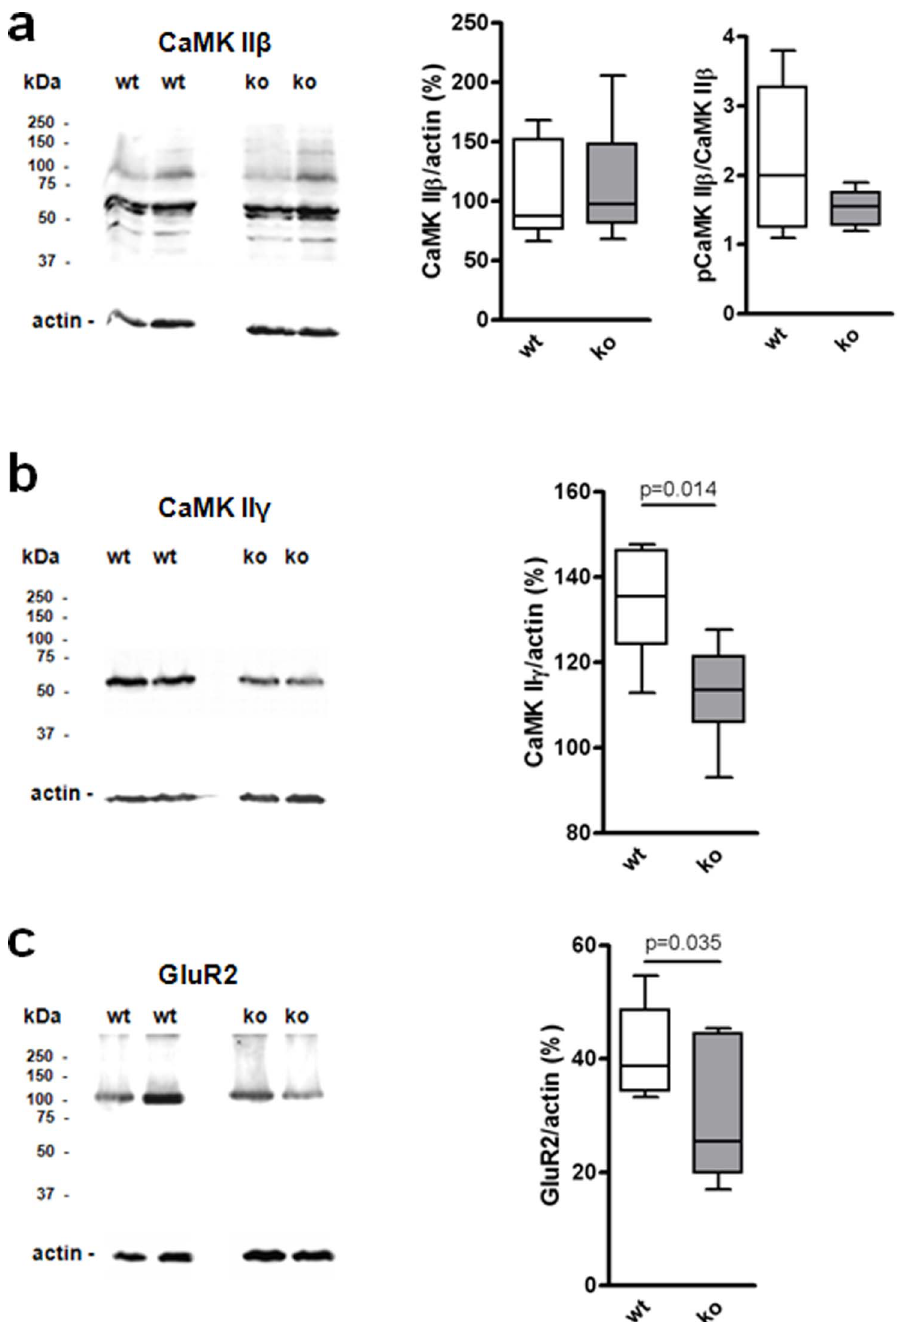
Figure 4. Western blot analyses of key proteins in striata of 3-month-old wt and RGS9-deficient mice. ( a ) CaMK II b expression (56 kDa) and phospho-CaMK II b expression (60 kDa) were not significantly changed in striata of RGS9-deficient mice. Phospho-CaMK II b is given relative to total CaMK II b . ( b, c ) CaMK II c expression and GluR2 expression were significantly decreased in striata of RGS9-deficient mice. Data were normalized to actin. Representative Western blots are shown, quantification was performed with n=6 (a, b) and n=7 (c) per genotype. dependent protein kinase C b 1 (PKC b 1) were significantly down- striatal dopaminergic signal transduction [16]. Indeed, our gene regulated. These findings can be interpreted as compensatory expression data are highly consistent with striatopallidal D2R regulation to counteract persistent overactivity of D2R-dependent hyperactivity in RGS9-deficient mice which is counteracted signaling. Unchanged basal cAMP levels in acute striatum biopsies through changes in mRNA expression levels of specific down- of wt and ko mice (Fig. 5a) may reflect the effectiveness of these stream signaling components. Transcript levels of all G-protein a i changes at the functional level and/or the minor importance of subunits, the downstream signaling components of G-protein bc AC inhibition by striatal D2R signal transduction. Indeed, we did heterodimers, PLC b 1 and the diacylglycerol- (DAG) and Ca 2 + -